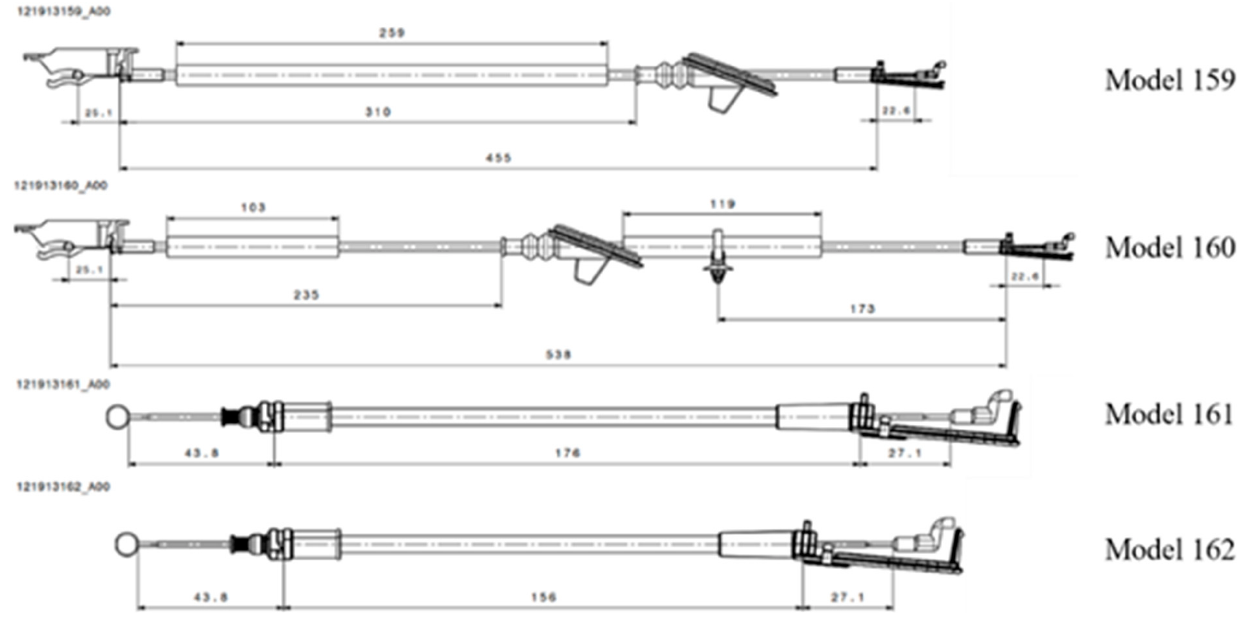
Figure 2. Models of control cables produced in the line BX726.